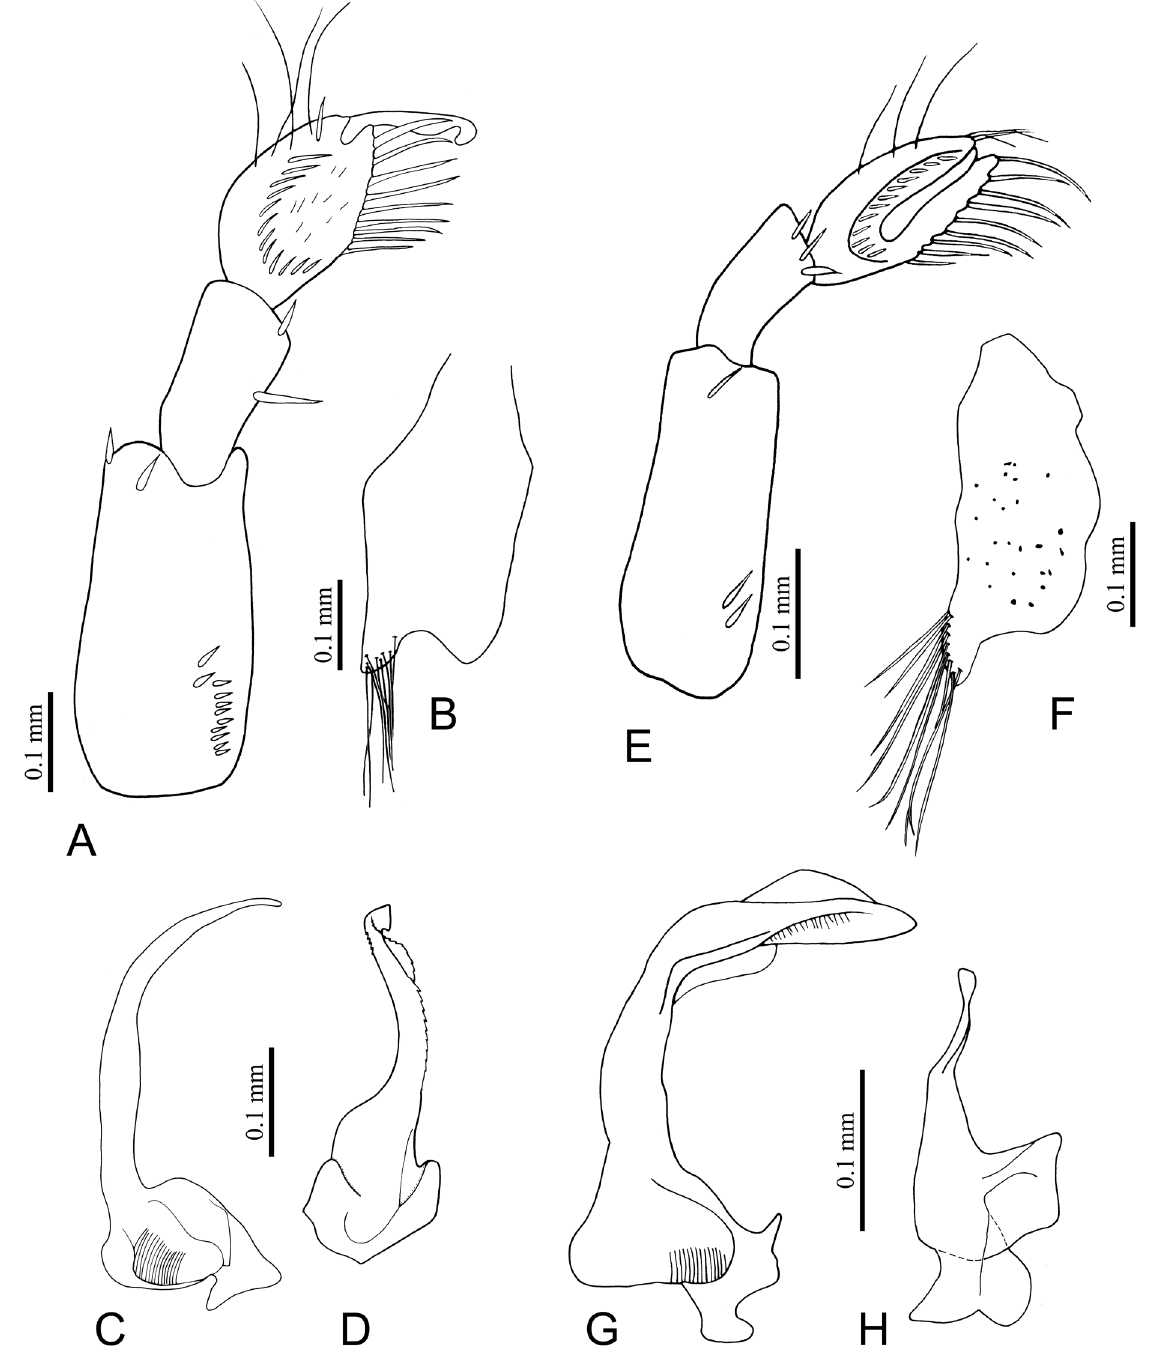
Fig. 6. Morphological features of species of Micronecta Kirkaldy, 1897, ♂♂. A–D . M. grisea (Fieber, 1844) (ZVNU). E–H . M. guttatostriata Lundblad, 1933 (ZVNU). A, E = fore leg; B, F = free lobe; C, G = right paramere; D, H = left